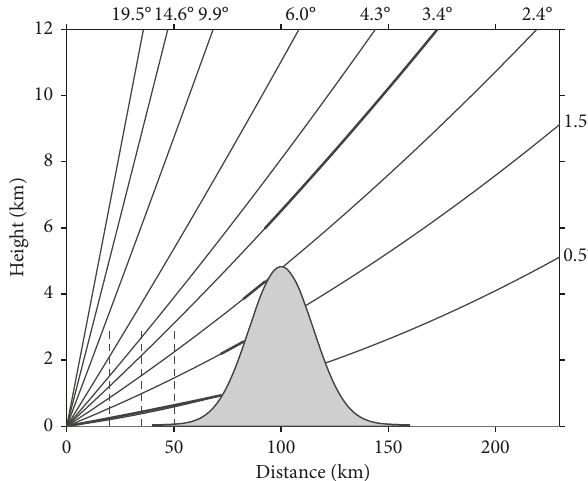
Figure 4: The computing method of radar effective coverage using all elevation tilts with considering terrain blockage. The radar is supposed to locate at original point (0, 0). The shadowed area denotes a mountain which blocks radar beams. The black bold lines are the adopted beams from the radar, and the dash lines represent different distances (e.g., 20km, 35km, and 50 km) from radar site.